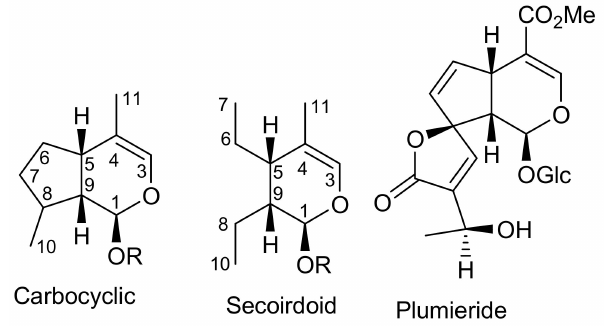
Figure 1. Basic skeletons of iridoids.